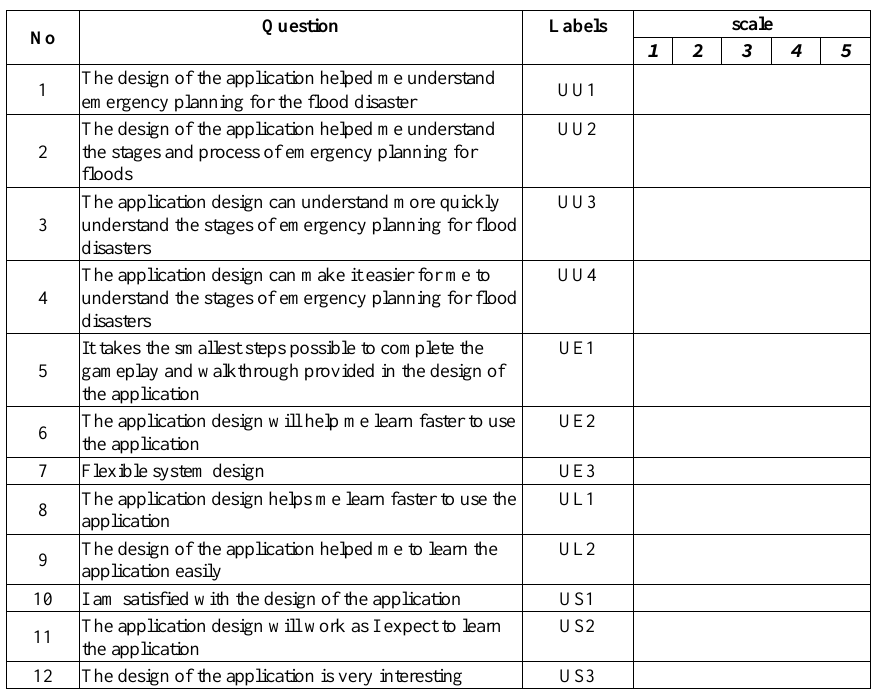
Table 3. Questioner Use [9].